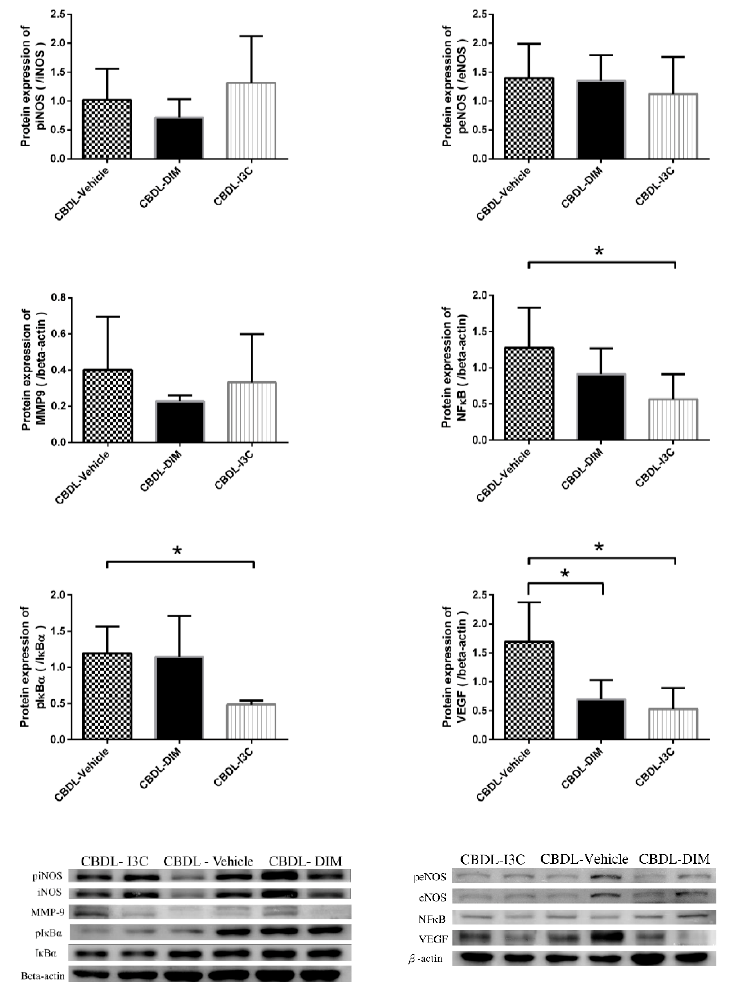
Figure 3. Mesenteric protein expressions of piNOS / iNOS, peNOS / eNOS, MMP-9, NF κ B p65, pI κ B α / I κ B α , VEGF in CBDL rats treated with vehicle, DIM, or I3C analyzed with ANOVA (* p < 0.05, DIM- or I3C-treated group vs. vehicle group). The representative images are shown below.